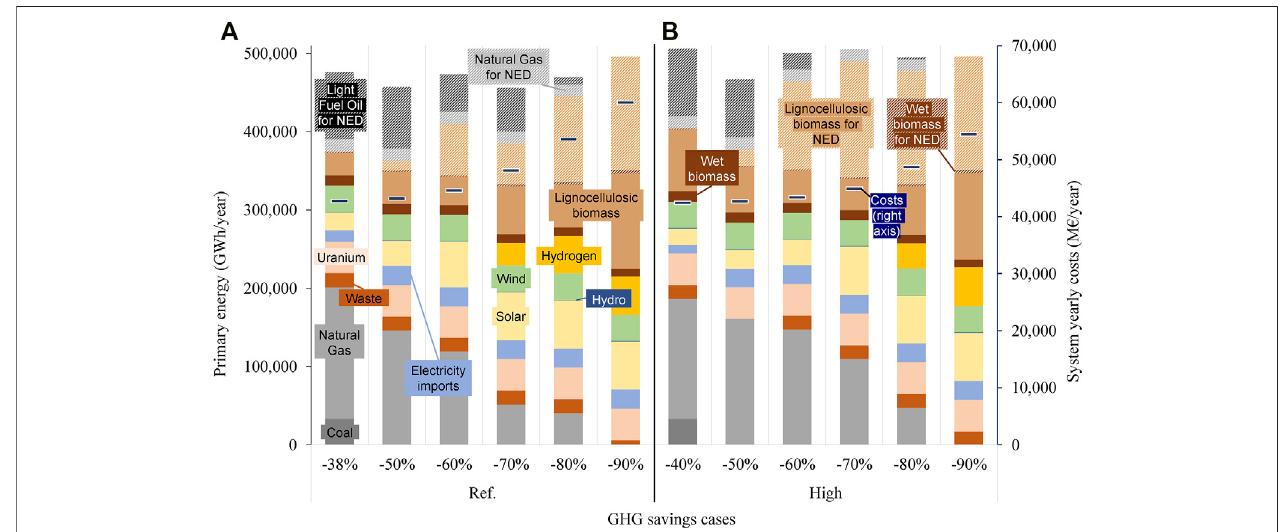
FIGURE 3 | Primary energy use by fuels for the different GHG savings cases (compared to 2015) and associated costs of the energy system for the reference (A) and high (B) potential scenarios (NED, non-energy demand).